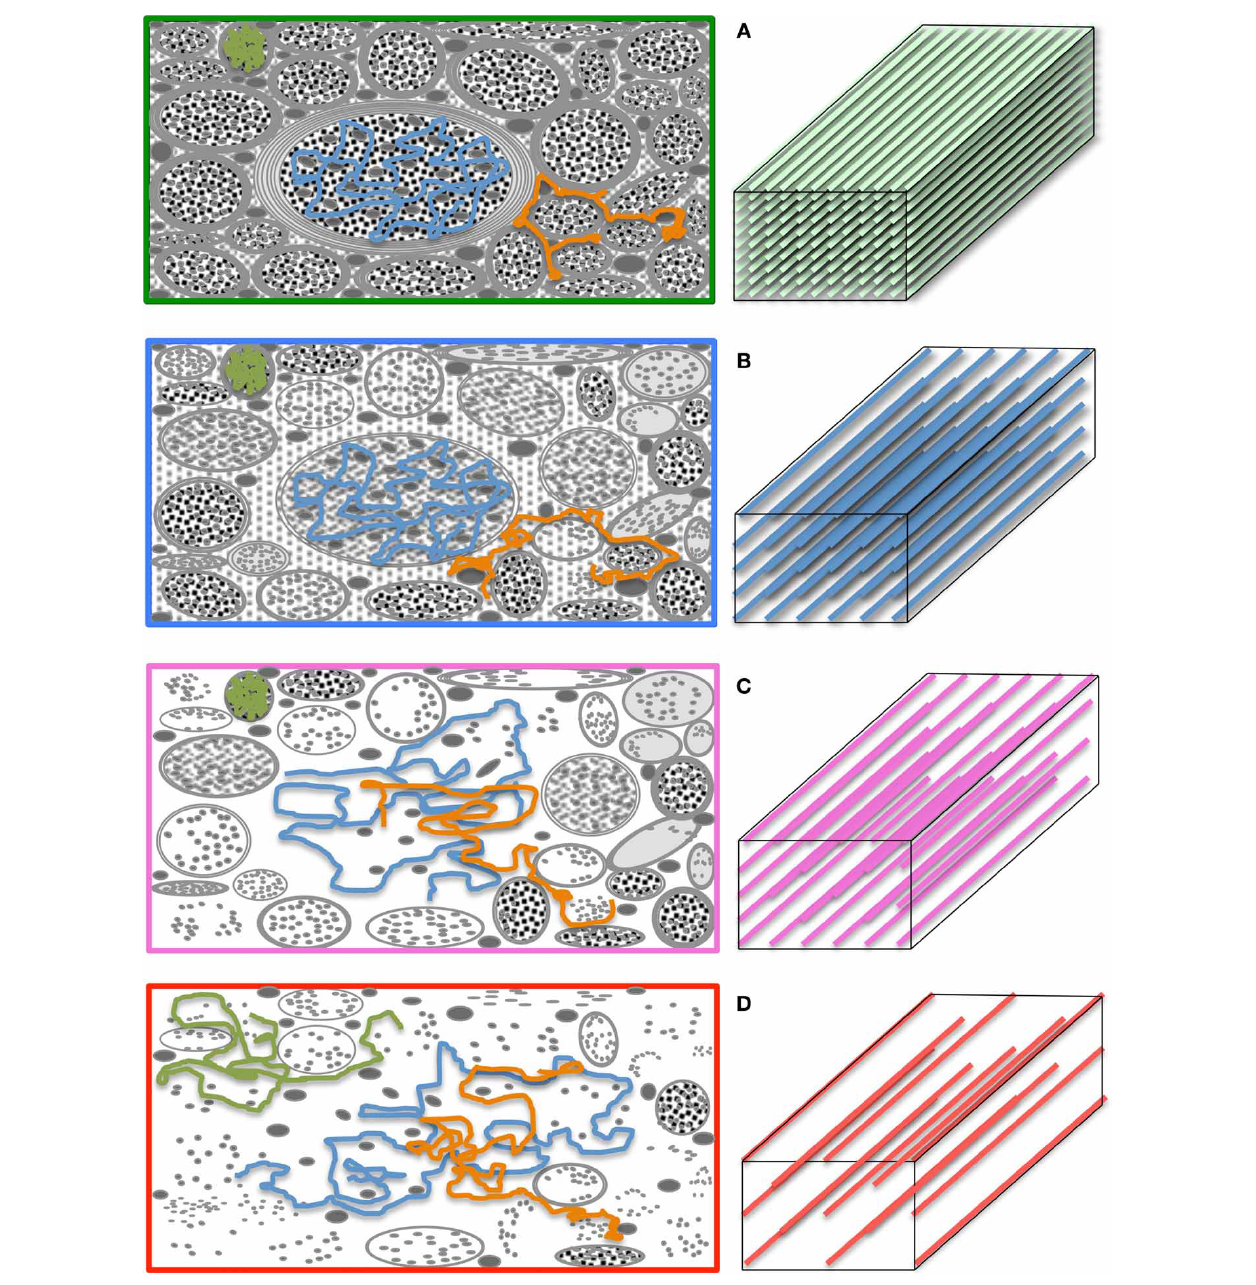
FIGURE 5 | The “diffusion regimes.” (A) White matter is a complex—but relatively ordered— microstructure primarily composed of nerve fibers (axons) and glial cells. Axons are bundled together; their main role is to transport substances intra-cellularly through microtubules and conduct electricity to enable inter-communication between cells. The myelin sheath—a “fatty” insulating layer around the axons—facilitates such conduction. In the healthy brain, such microstructure exerts restrictive boundary conditions to water diffusion. (B) The exact mechanism by which microstructural damage occurs in neurodegenerative diseases is unknown but it is conceivable that, after a period of instability, demyelinative and other axon degeneration processes will lead to longer “diffusion paths.” If therefore, the diffusion time is sufficiently long and the gradients